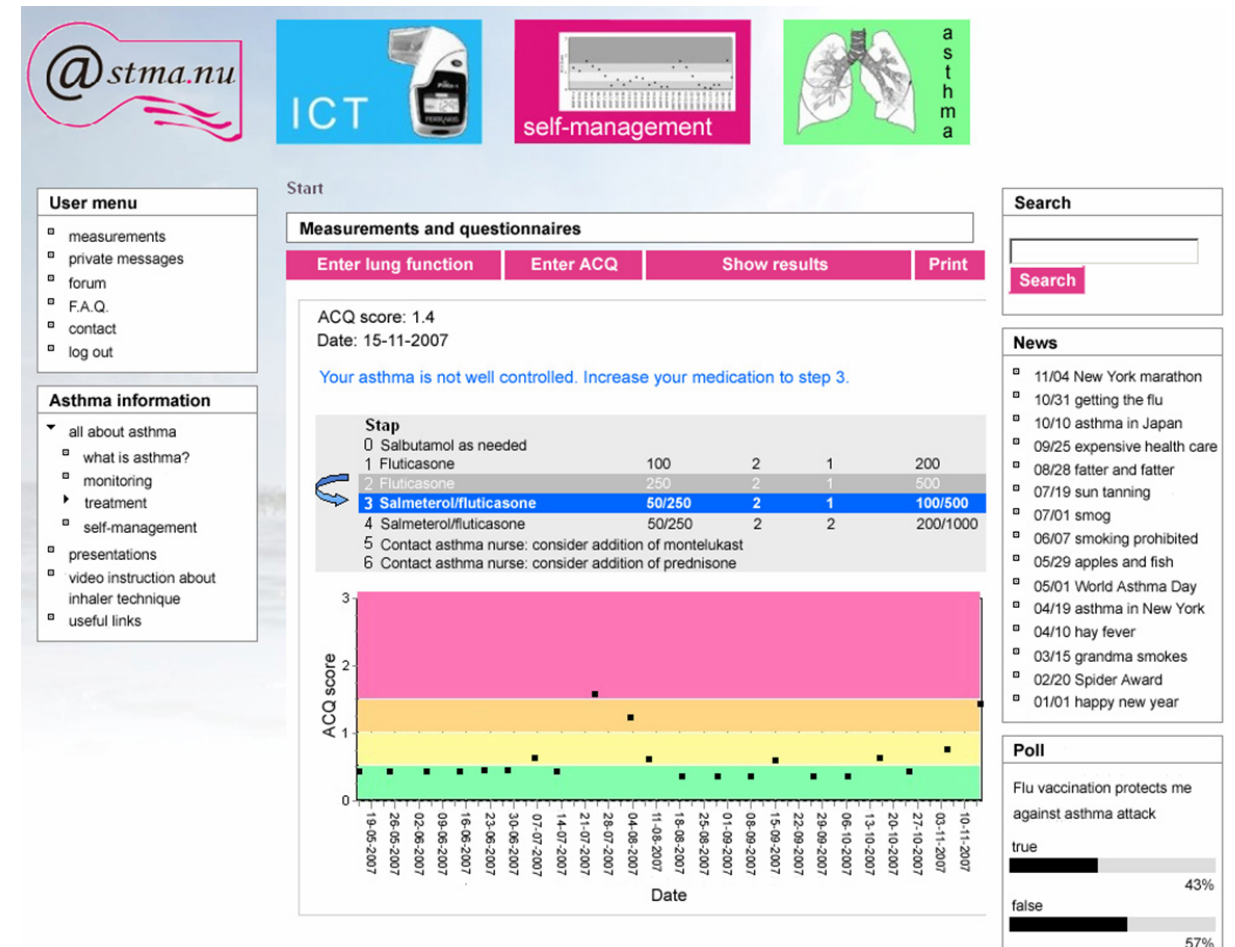
Figure 2. Traffic light